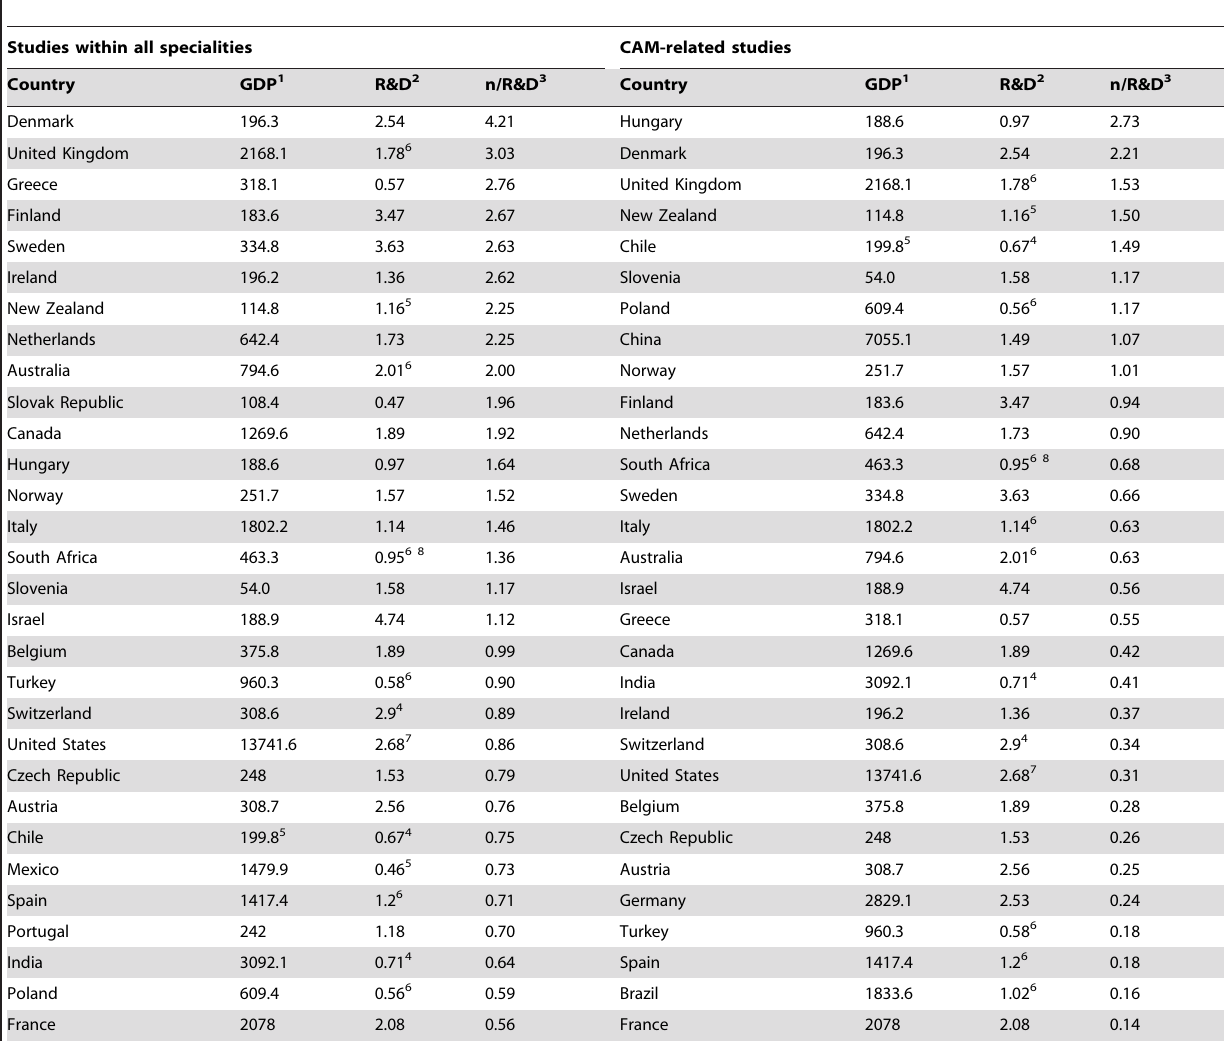
Table 3. Spending on research and development of each country and ‘‘studies for money’’ within all specialities (left) and CAM- related studies